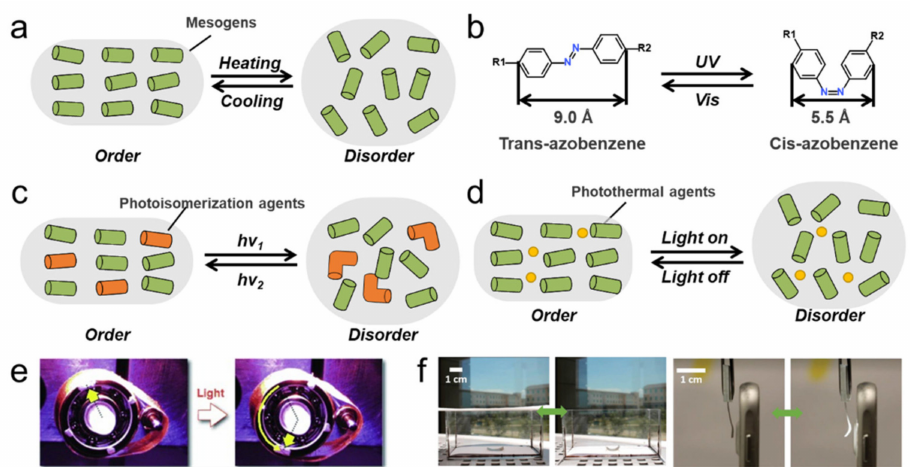
Figure 4. ( a ) Schematic representation of thermal-induced order-disorder phase transition in LCEs. ( b ) Reversible trans-cis photoisomerization of azobenzenes. ( c ) Schematic representa- tion of photo-induced order-disorder phase transition in LCEs. ( d ) Schematic representation of photothermal-induced order-disorder phase transition in LCEs. ( e ) A light-driven plastic motor with the azobenzene-containing LCE laminated film [112] (Reproduced with permission from Yamada, M.; Kondo, M.; Mamiya, J.; Yu, Y.; Kinoshita, M.; Barrett, C.J.; Ikeda, T., Angewandte Chemie Interna- tional Edition; Copyright 2008 John Wiley and Sons.) ( f ) Photothermal bending actuation triggered by sunlight (100 mW cm − 2 ) and the light emitting diode on a mobile phone (150 mW cm − 2 ) [86] (Reproduced with permission from Kim, H.; Lee, J.A.; Ambulo, C.P.; Lee, H.B.; Kim, S.H.; Naik, V.V.; Haines, C.S.; Aliev, A.E.; Ovalle-Robles, R.; Baughman, R.H.; et al., Adv. Funct. Mater.; Copyright 2019 John Wiley and